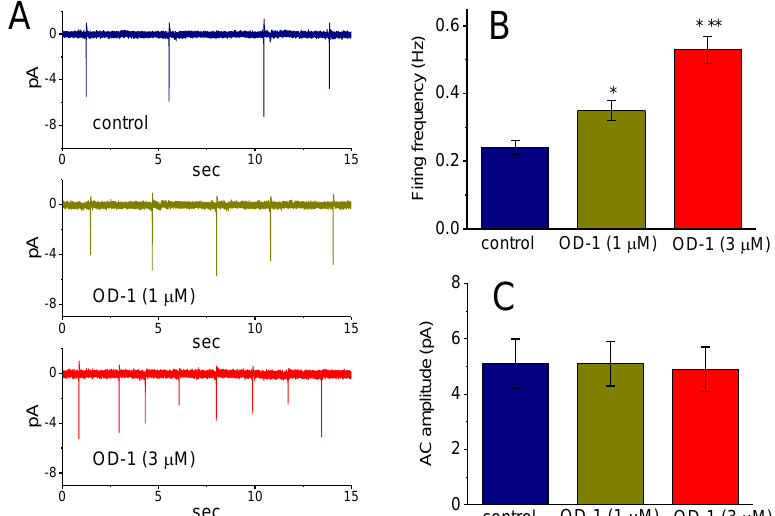
Figure 3. Stimulatory e ff ect of OD-1 on AC frequency and amplitude. Cell-attached voltage-clamp current recordings were made in these experiments. The recording pipette was filled with a K + -containing solution, and once the cell-attached model was clearly achieved, the potential was maintained at the resting potential of the cell ( − 70 mV). ( A ) Representative current traces obtained in the absence (upper) and presence of 1 µ M OD-1 (middle) and 3 µ M OD-1 (lower). The results regarding the addition of OD-1 were obtained 2 min after the cells were exposed to the compound (1 or 3 µ M). Note that the trace displaying inward deflections reflects the emergence of ACs. Summary bar graphs showing the e ff ect of OD-1 on the frequency and amplitude of spontaneous ACs are shown in ( B ) and ( C ), respectively, (mean ± SEM; n = 11). * Significantly di ff erent from the control group ( p < 0.05). ** Significantly di ff erent from OD-1 (1 µ M; p < 0.05). Data were analyzed using a one-way ANOVA with the least-significant di ff erence post hoc